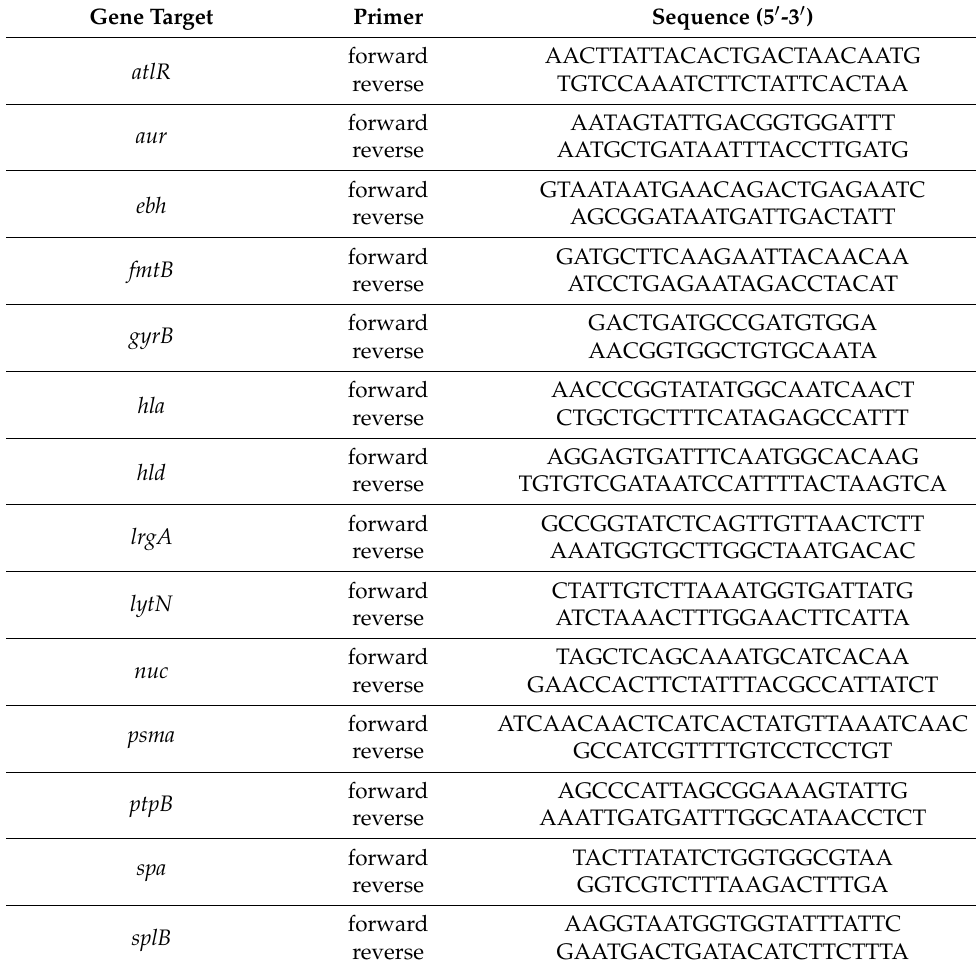
Table 2. qRT-PCR primer used in this